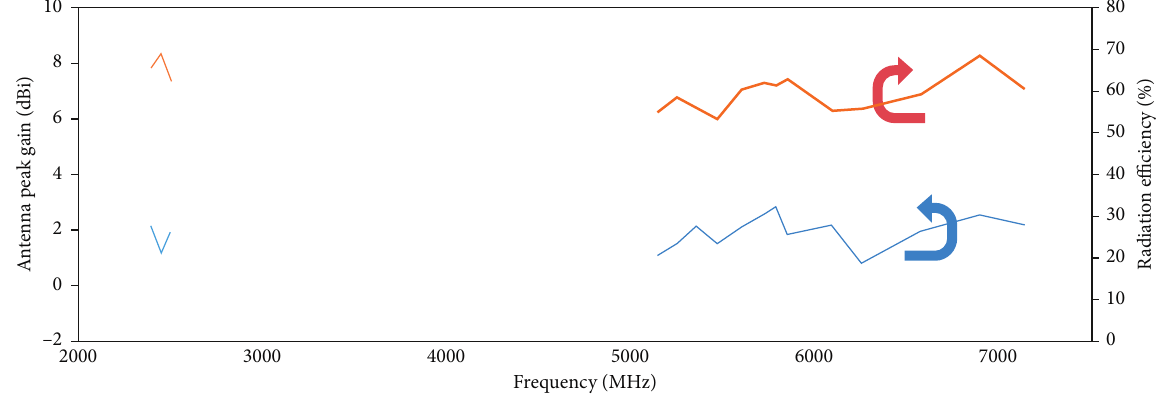
Figure 10: Measured of fain and radiation efficiency of antenna at 2400–2484 and